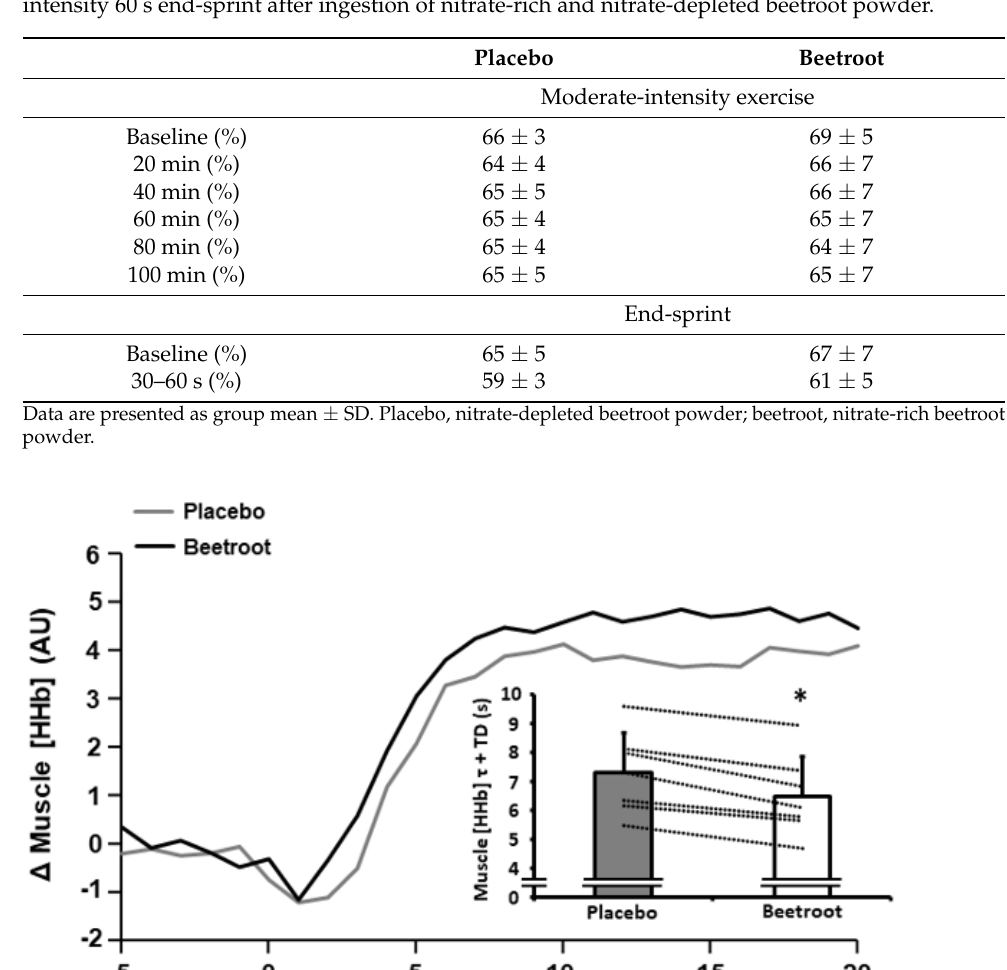
Table 3. Tissue saturation index during 2 h moderate-intensity exercise terminating in a maximal- intensity 60 s end-sprint after ingestion of nitrate-rich and nitrate-depleted beetroot powder.